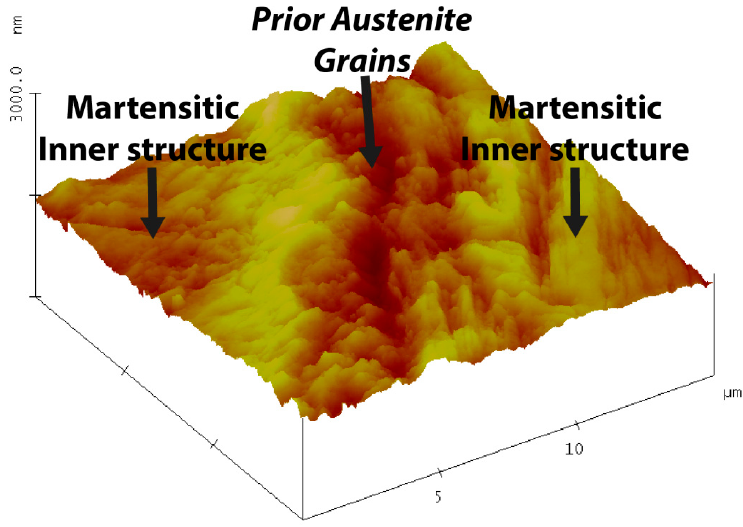
Figure 8. Etched surface image obtained by atomic force microscopy, showing the martensitic inner structure and the prior austenite grain boundaries.